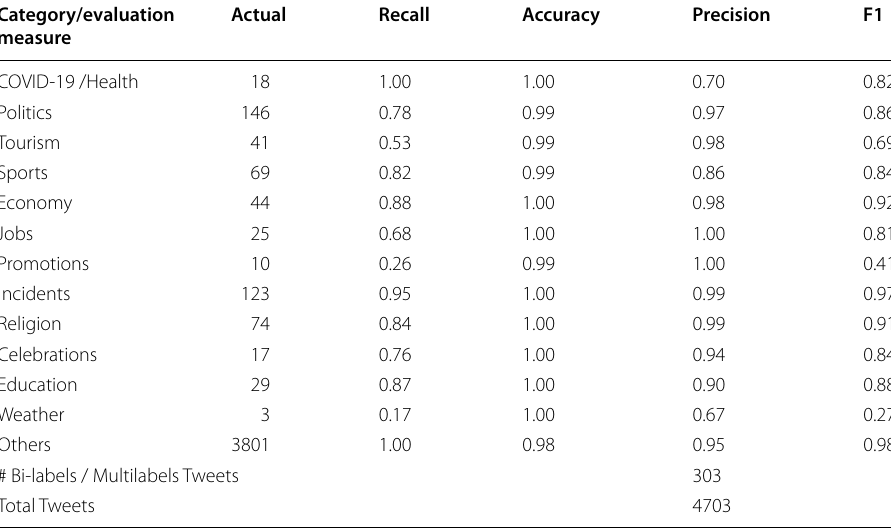
Table 2 Evaluation results of the supervised learning approach Category/evaluation